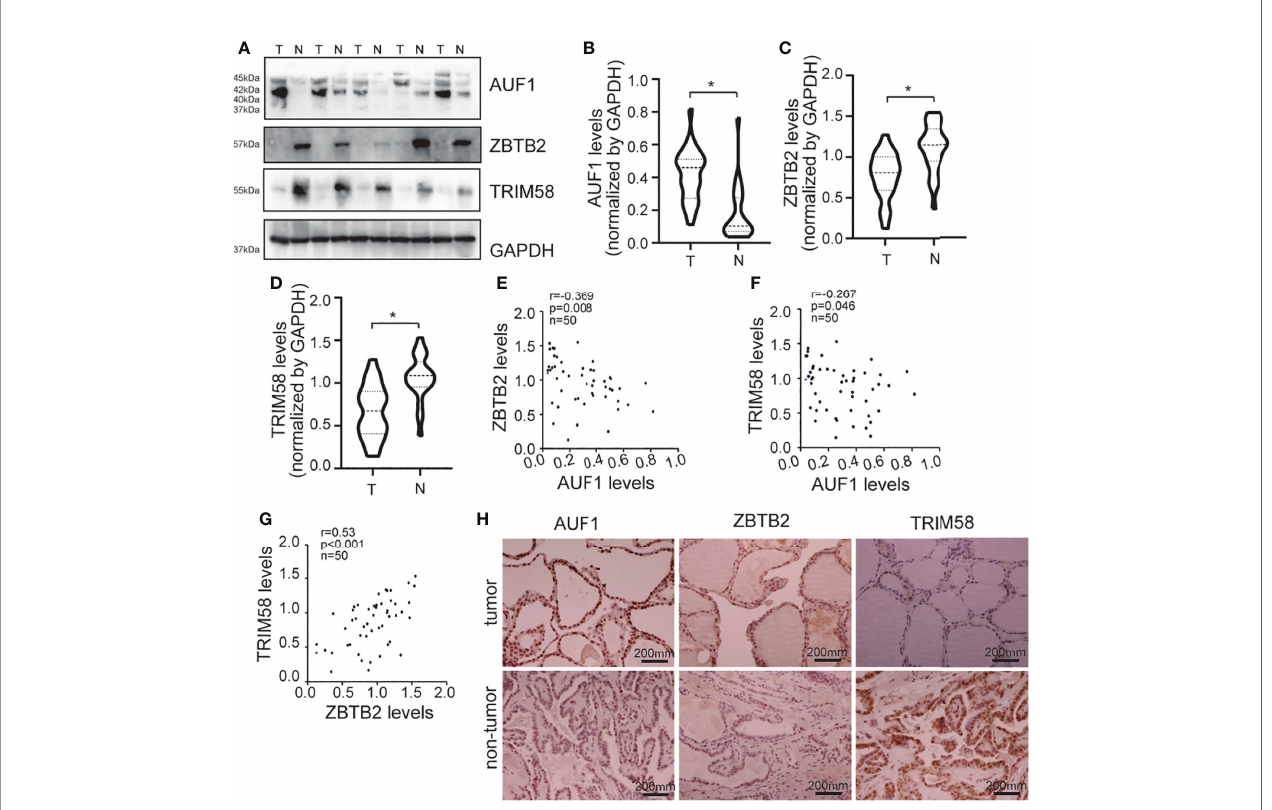
FIGURE 7 | AUF1, ZBTB2, and TRIM58 expression in normal and tumoral human thyroid tissues. (A) Western blot was applied to observe the expression difference of AUF1, ZBTB2, and TRIM58 between a total of 36 paired papillary cancer (T) and peripheral normal (N) tissues, a representative blot was shown; (B) the Western blot results in panel A were quantitatively analyzed and normalized by GAPDH, and the AUF1 levels in papillary cancer (T) and peripheral normal (N) tissues were counted and compared, n = 36, *P < 0.05; (C) and the ZBTB2 levels in papillary cancer (T) and peripheral normal (N) tissues were counted and compared, n = 36, *P < 0.05; (D) the TRIM58 levels in papillary cancer (T) and peripheral normal (N) tissues were counted and compared, n = 36, *P < 0.05; (E) correlation analysis showed that the protein expression levels of ZBTB2 and AUF1 were negatively correlated. n = 50, p = 0.008, r = − 0.369; (F) correlation analysis showed that the protein expression levels of TRIM58 and AUF1 were negatively correlated. n = 50, p = 0.046, r = − 0.267; (G) correlation analysis showed that the protein expression levels of ZBTB2 and TRIM58 were positively correlated. n = 50, p = 0.001, r = 0.53; (H) immunohistochemical staining was applied to the human non-tumor tissue and tumor tissue to detect the expression levels of AUF1, ZBTB2, and TRIM58, and the corresponding representative pictures under microscope (scale bar, 200 m m) were